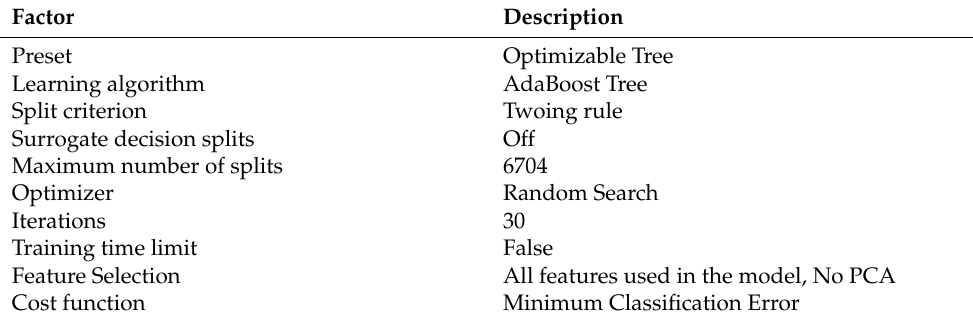
Table 2. Optimized parameters for the development of O-DT.